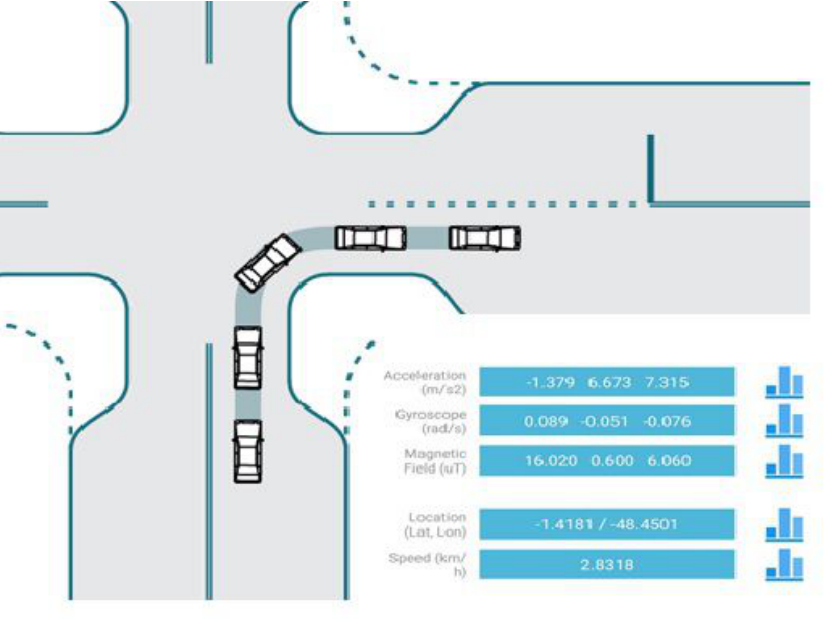
Figure 4. Activated sensors at the beginning of the curve.